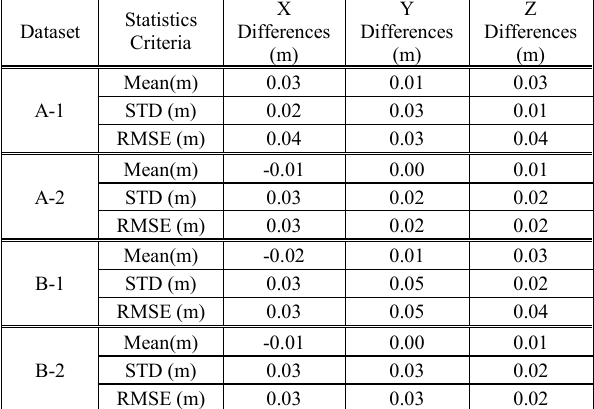
Table 3. Mean, STD, and RMSE of the differences between LiDAR-derived and RTK-GNSS coordinates of the twelve check points for the four datasets.